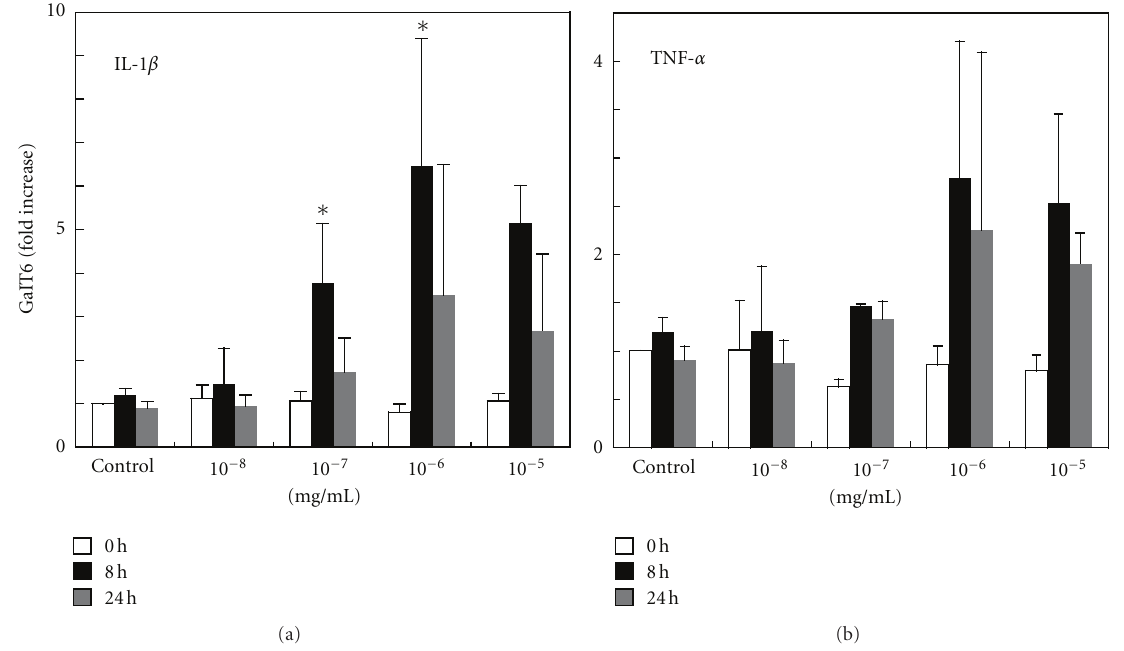
Figure 2: Real-time quantitative PCR analysis of GalT6 mRNA induction in HASTs treated with IL-1 β and TNF- α . Expression of GalT6 mRNA was examined by real-time quantitative PCR using HASTs treated with IL-1 β (10 − 8 to 10 − 5 mol/L) (a) and TNF- α (10 − 8 to 10 − 5 mol/L) (b) for 8 or 24 h. The levels of induction of GalT6 mRNA expression were calculated relative to the control cultures. Data are expressed as the fold increase of mRNA (mean ± SD; SD values from five independent experiments). Comparison of GalT6 mRNA levels elicited by treatment with IL-1 β or TNF- α with those of the untreated control. ∗ P < 0 .